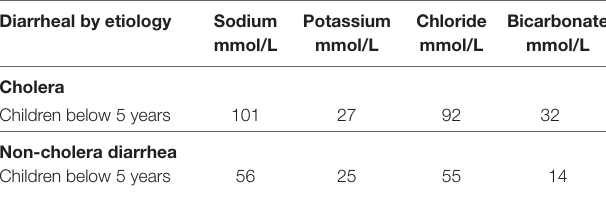
TABLe 2 | Average electrolyte content of stool in acute watery diarrhea